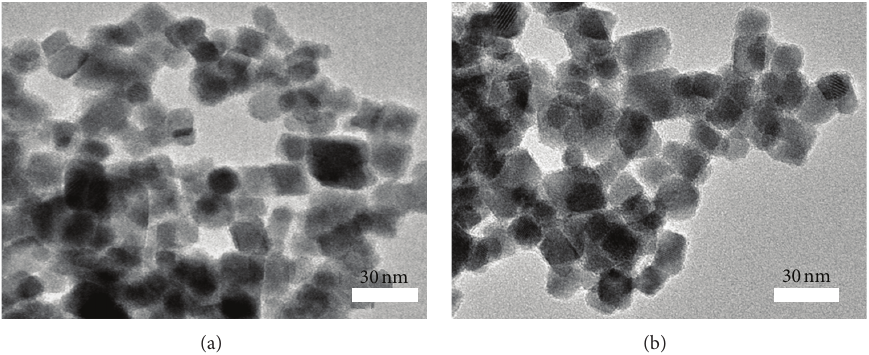
Figure 3: TEM images of (a) BSO sample and (b) 1%-Pr-BSO sample.